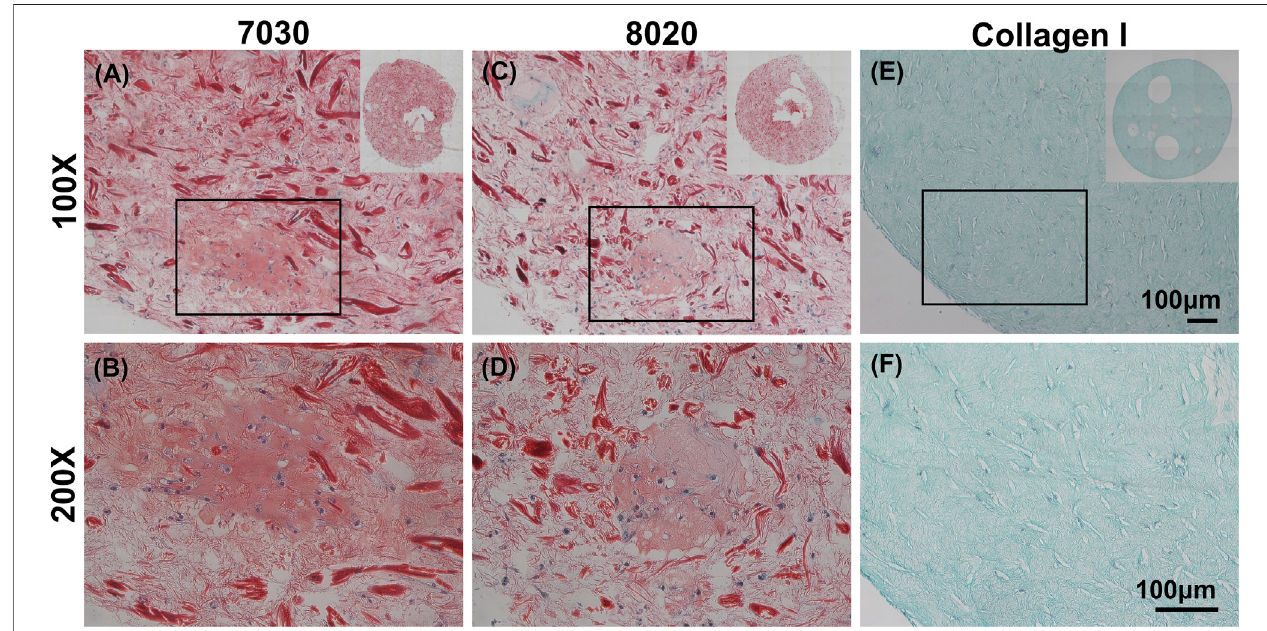
FIGURE 5 | Safranin-O staining (red, stained negatively charged proteoglycans and the TCNF) with Fast Green counterstain (green, stained proteins) and cells stained with hematoxylin of (A,B) 7030, (C,D) 8020, and (E,F) COL I bioinks. Scale bar is 100 μ m.